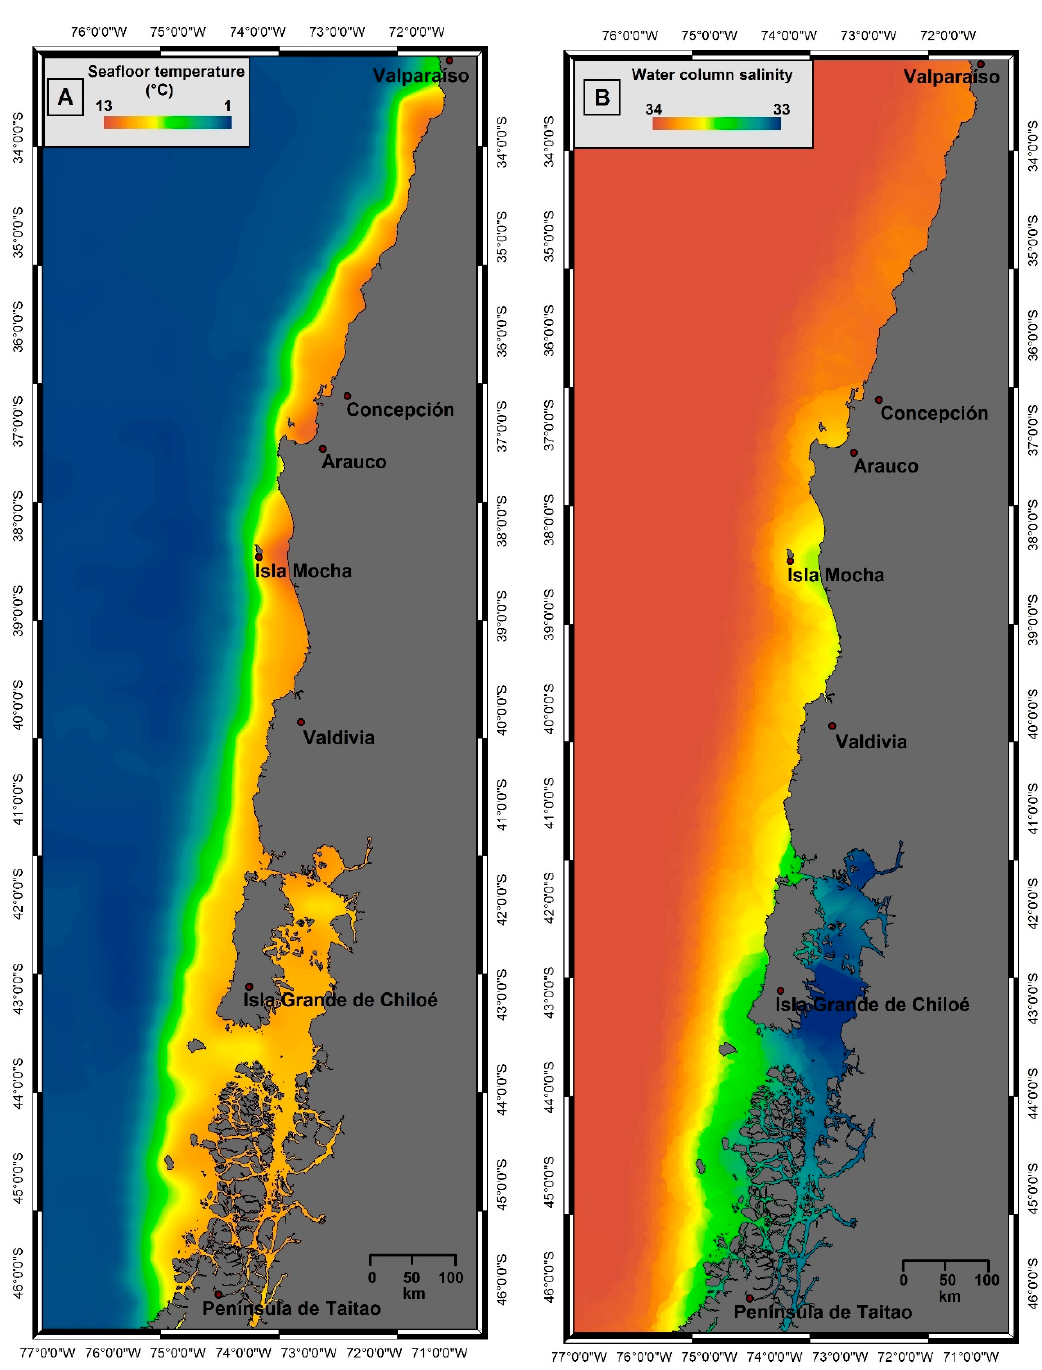
Figure 2. ( A ) Seafloor temperature grid. ( B ) Water column salinity grid.